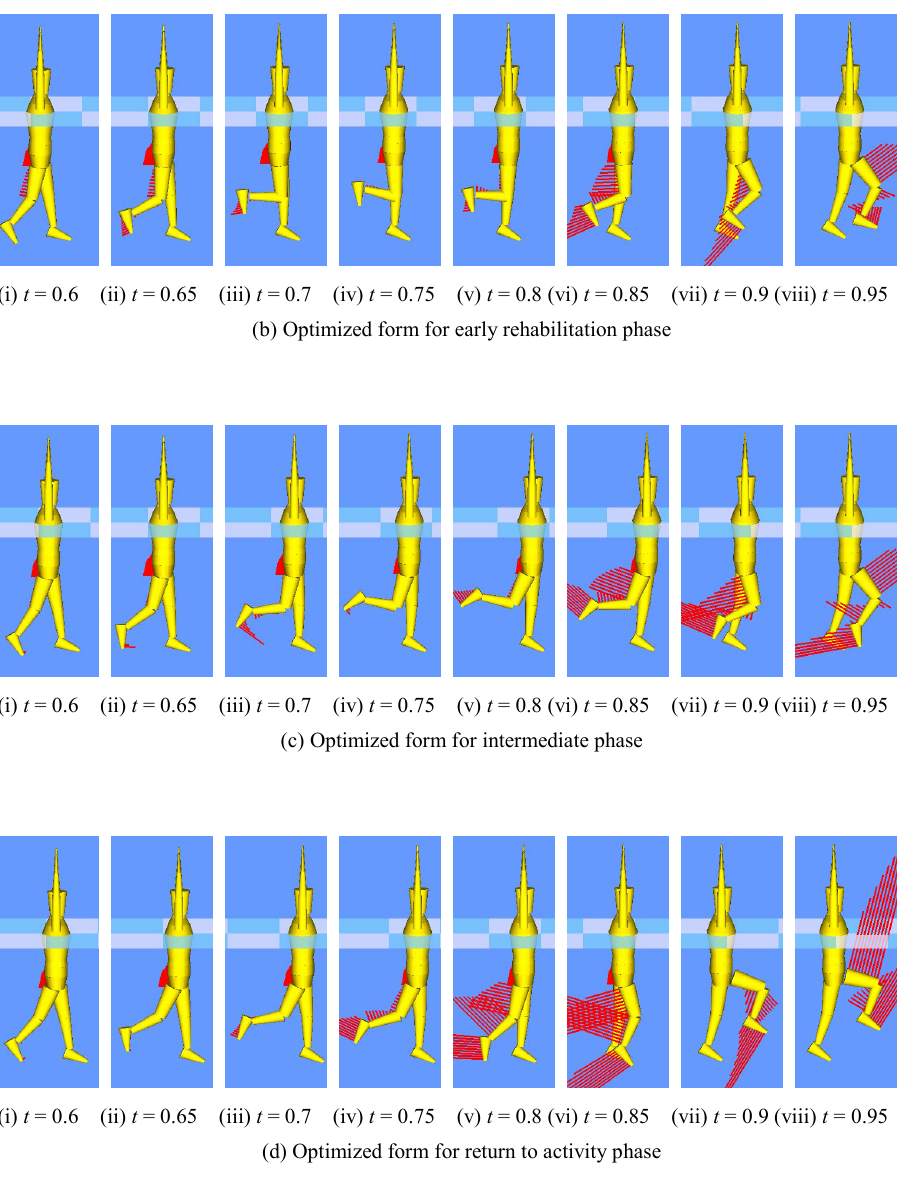
Fig. 6 Animation images of forms before and after